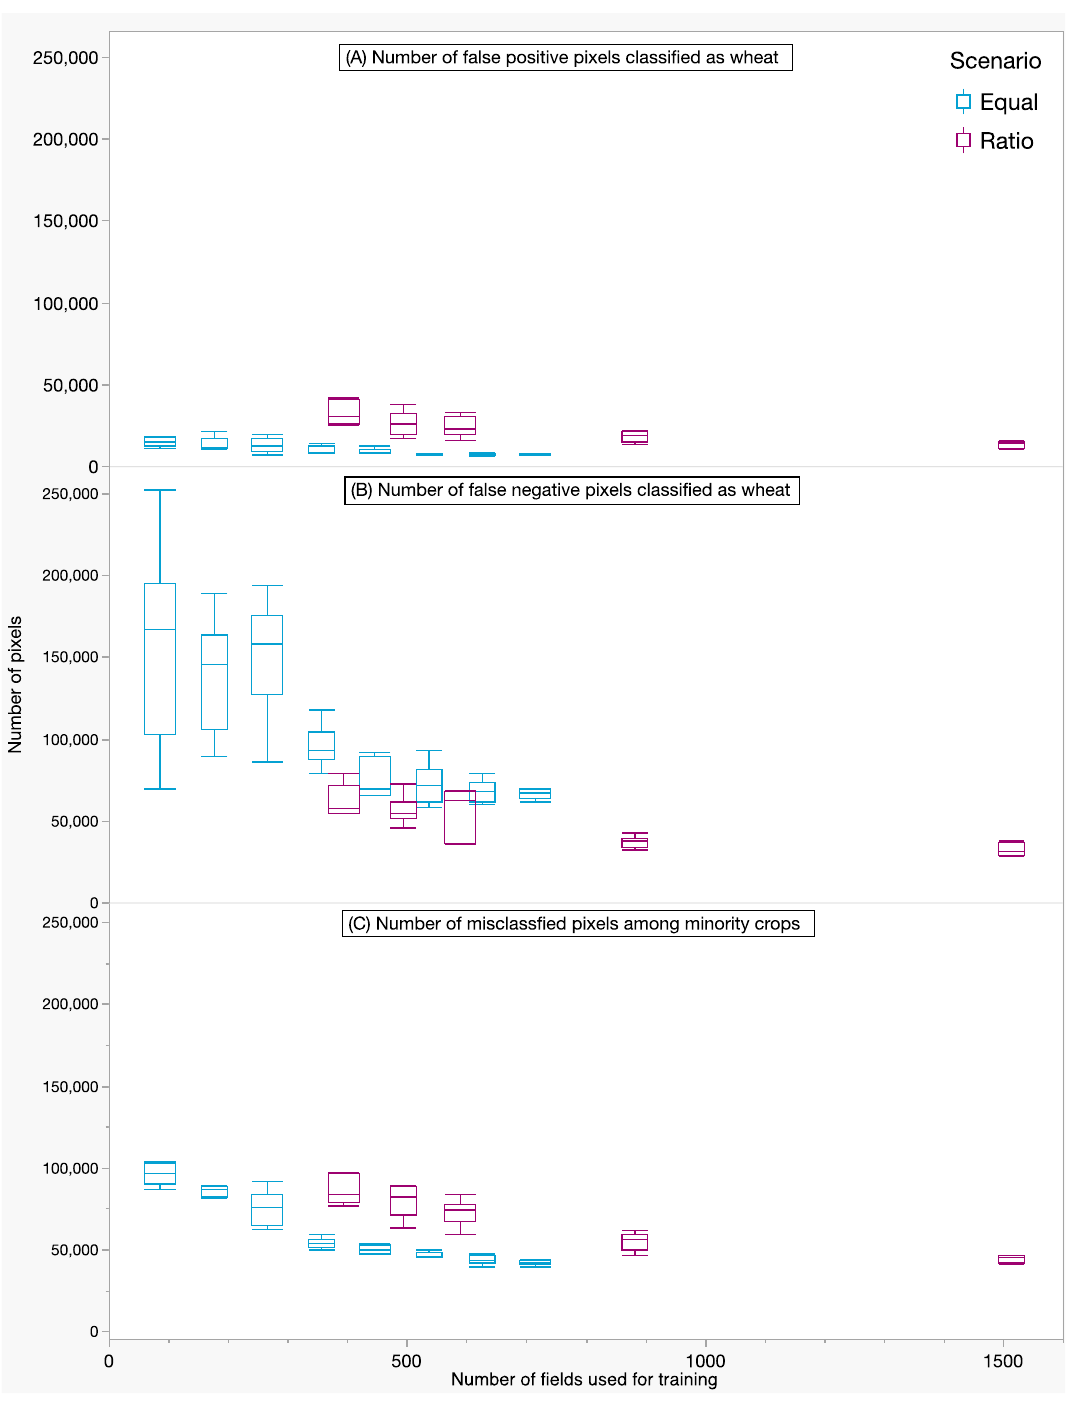
Figure 6. Effect of the number of fields used in the set of training data and scenario, Equal or Ratio, on the number of false positive ( A ) and false negative ( B ) pixels in the validation data set classified as wheat. The number of misclassified pixels among the non-wheat crops is shown in ( C ). Box plots represent results from six random selections of training data for each classification scenario.